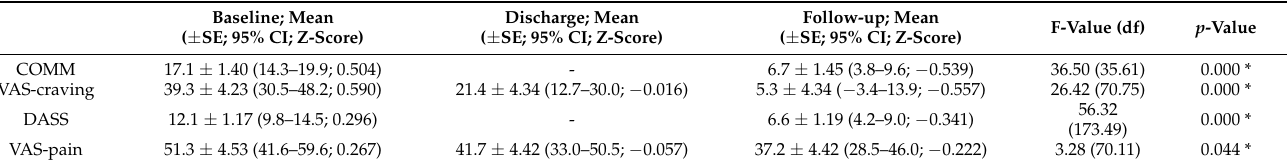
Table 2. Mean values of the dependent variables, combined with the corresponding p - and F-values. Baseline; Mean Discharge; Mean ( ± SE; 95% CI; Z-Score) ( ± SE; 95% CI;